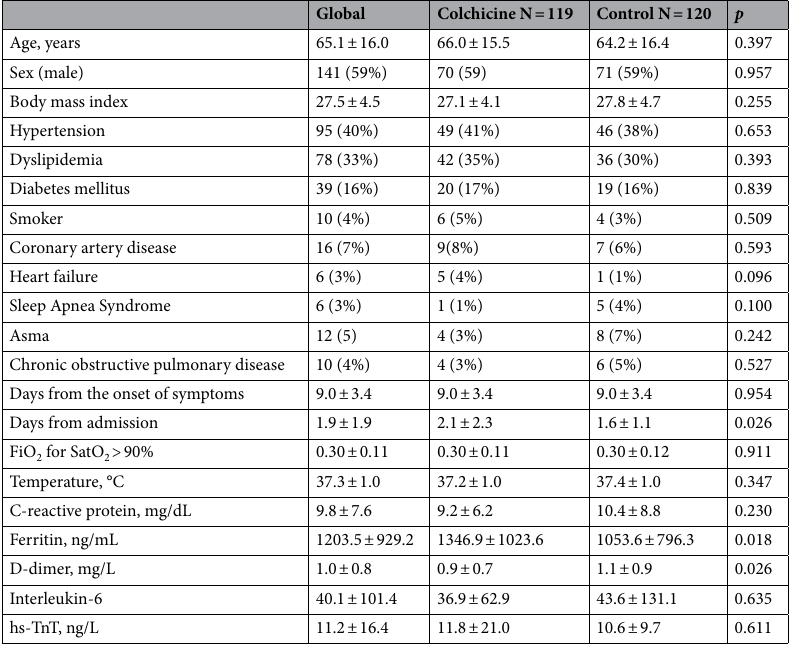
Table 1. Baseline characteristics. hs-TnT high sensitive Troponin T.